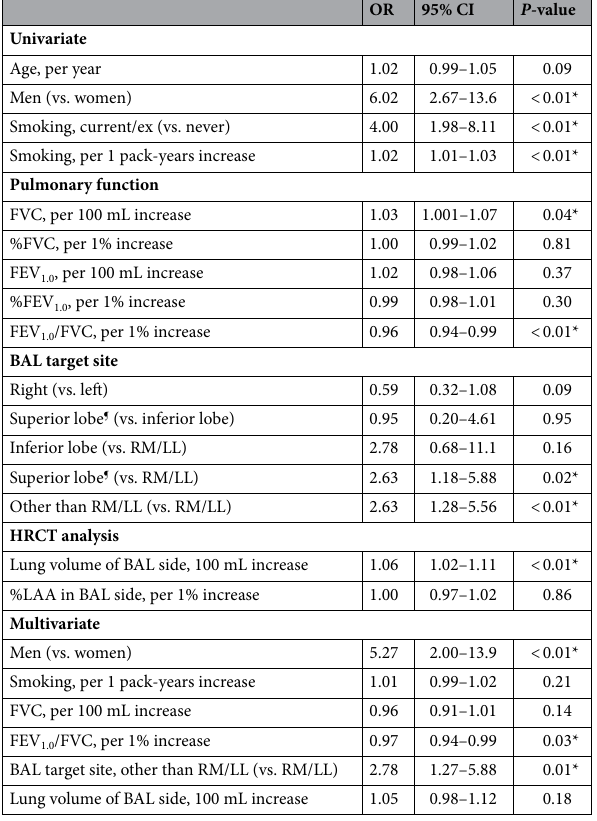
Table 3. Results of logistic regression analysis for BALF recovery failure in derivation cohort. BAL bronchoalveolar lavage, BALF BAL fluid, OR odds ratio, CI confidence interval, FVC forced vital